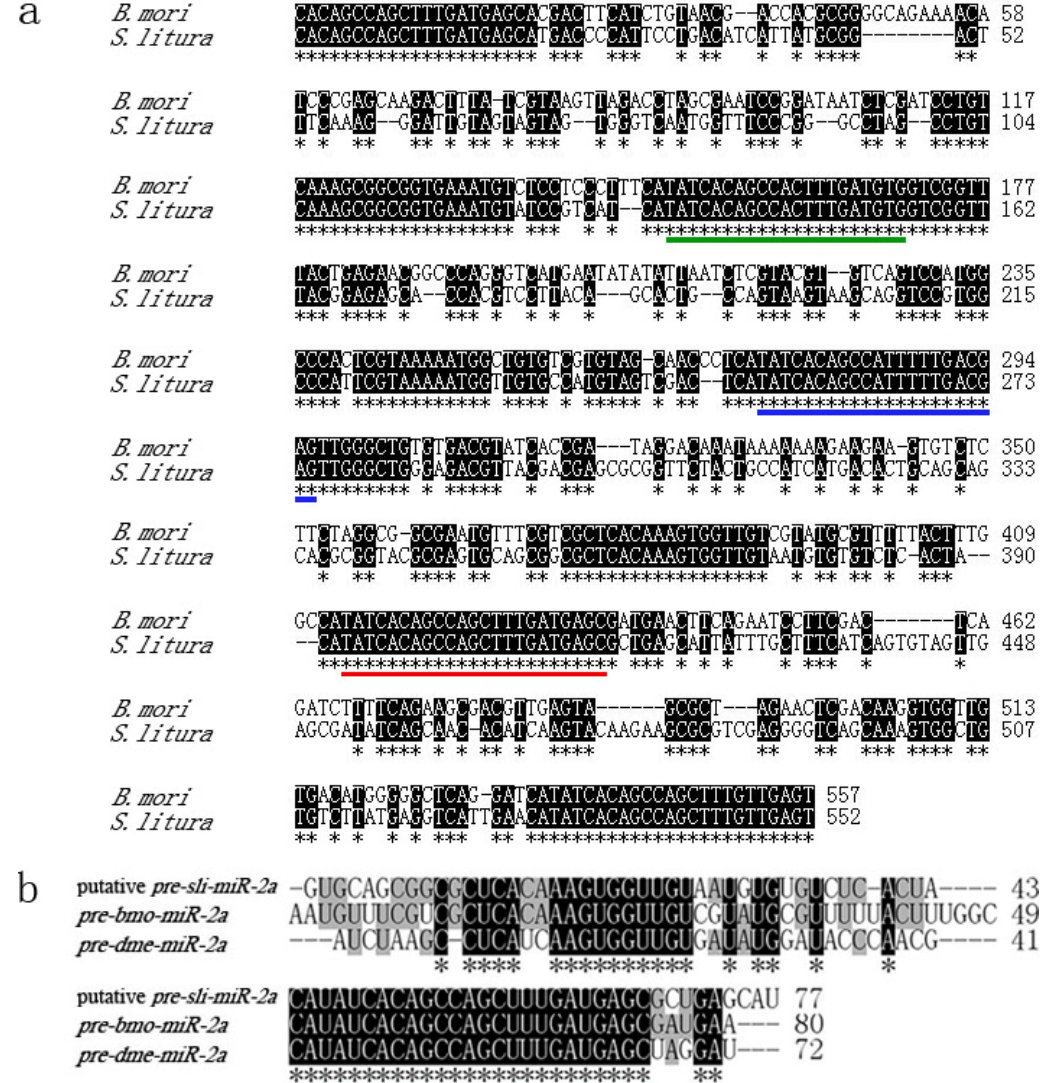
Figure 3. ( a ) The sequence alignment of partial sequences of pri-miR-2a between S. litura and B. mori ; ( b ) The sequence alignment of entire sequences of pre-miR-2a among S. litura , B. mori and D. melanogaster . Black shades represent completely conserved bases. Mature sequence of sli-miR-2a was underlined by red line, putative sli-miR-13a and sli-miR-13b were also underlined by green and blue line,